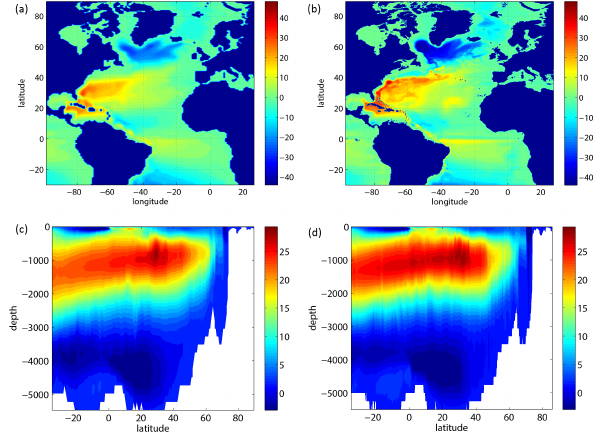
Figure 5. 45-year averaged barotropic and AMOC stream functions (in Sv) for ORCA1-R07 (a, c) and ORCA025-G70 (b, d) , respec-